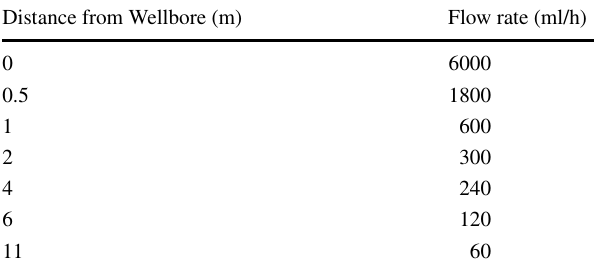
Table 3 Calculated laboratory flow rates based on distance to the wellbore Distance from Wellbore (m) Flow rate